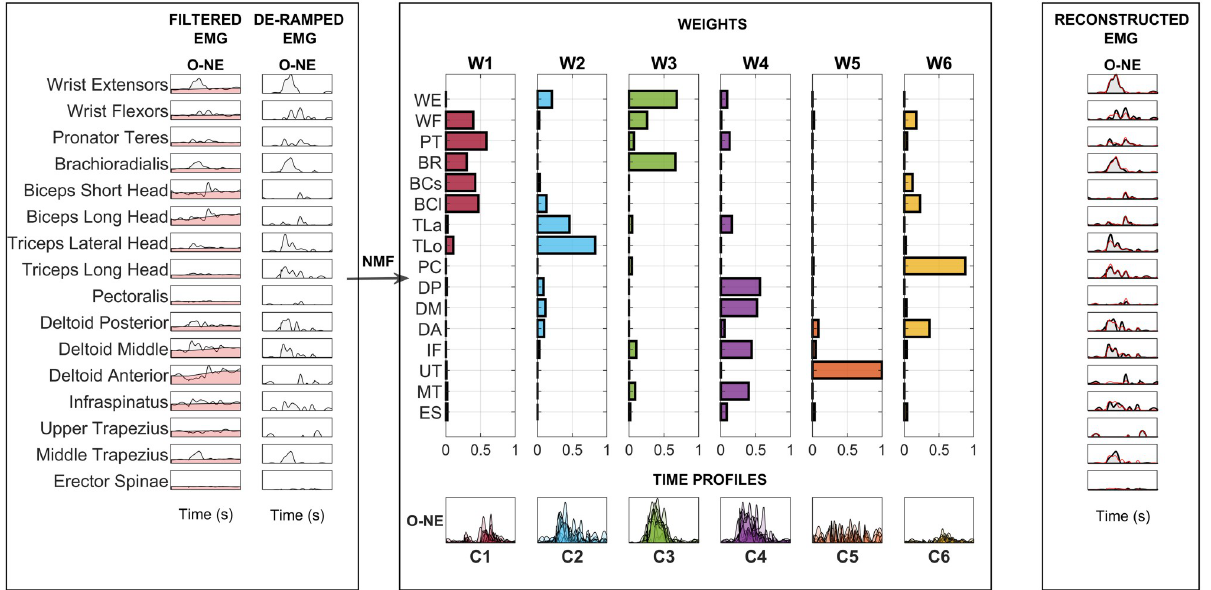
Fig 5. EMG elaboration and spatial synergies extraction. In the left panel, the aligned and filtered EMG envelopes are reported in light gray for a representative subject, condition and task (O-NE). In light red, the ramp model for tonic activity is portrayed. The phasic EMG activity is achieved by subtracting the tonic activity from the original envelopes. The normalization and zero-clipping procedures have been applied in order to remove the negative phasic components (center panel) and apply the standard NMF method. In the center panel, we showed the extracted spatial synergies and the temporal coefficients in the same representative task. The C coefficients are here shown for all the 10 repetitions, overlapped one with the other. In the right panel, in red, the reconstructed EMG envelopes are shown for a representative subject and condition respectively. In light gray, the original EMG envelopes are